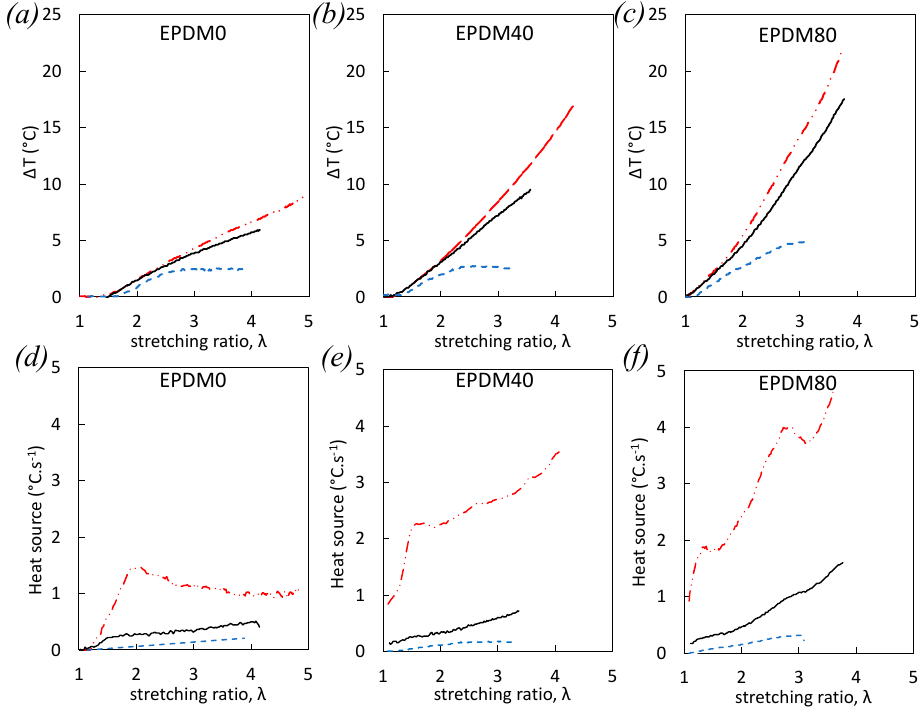
Figure 4. Self-heating versus strain for EPDM-0 ( a ), EPDM-40 ( b ), and EPDM-80 ( c ) during single uniaxial loading at the nominal strain rates 10 − 2 s − 1 (blue dotted line), 10 − 1 s − 1 (black continuous line), and 1 s − 1 (red dashed dotted line). Corresponding heat source versus strain for EPDM-0 ( d ), EPDM-40 ( e ), and EPDM-80 ( f